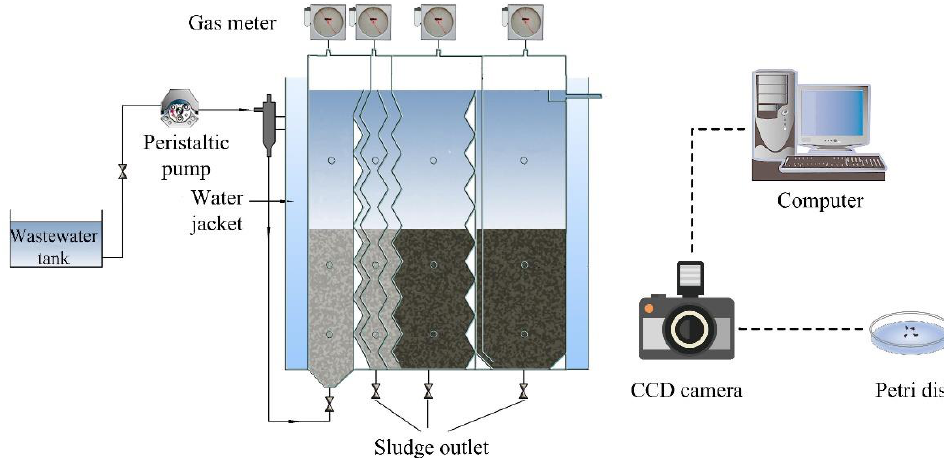
Figure 1. Schematic diagram of the experimental apparatus.